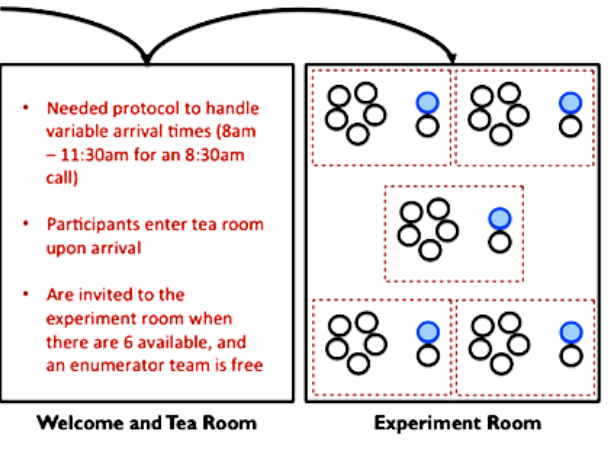
Fig. 4 . Experimental setup. Farmers directed to welcome room upon arrival and escorted by enumerators to experiment room when six players were available. Enumerator (filled circle) sat separately with current player during each turn.